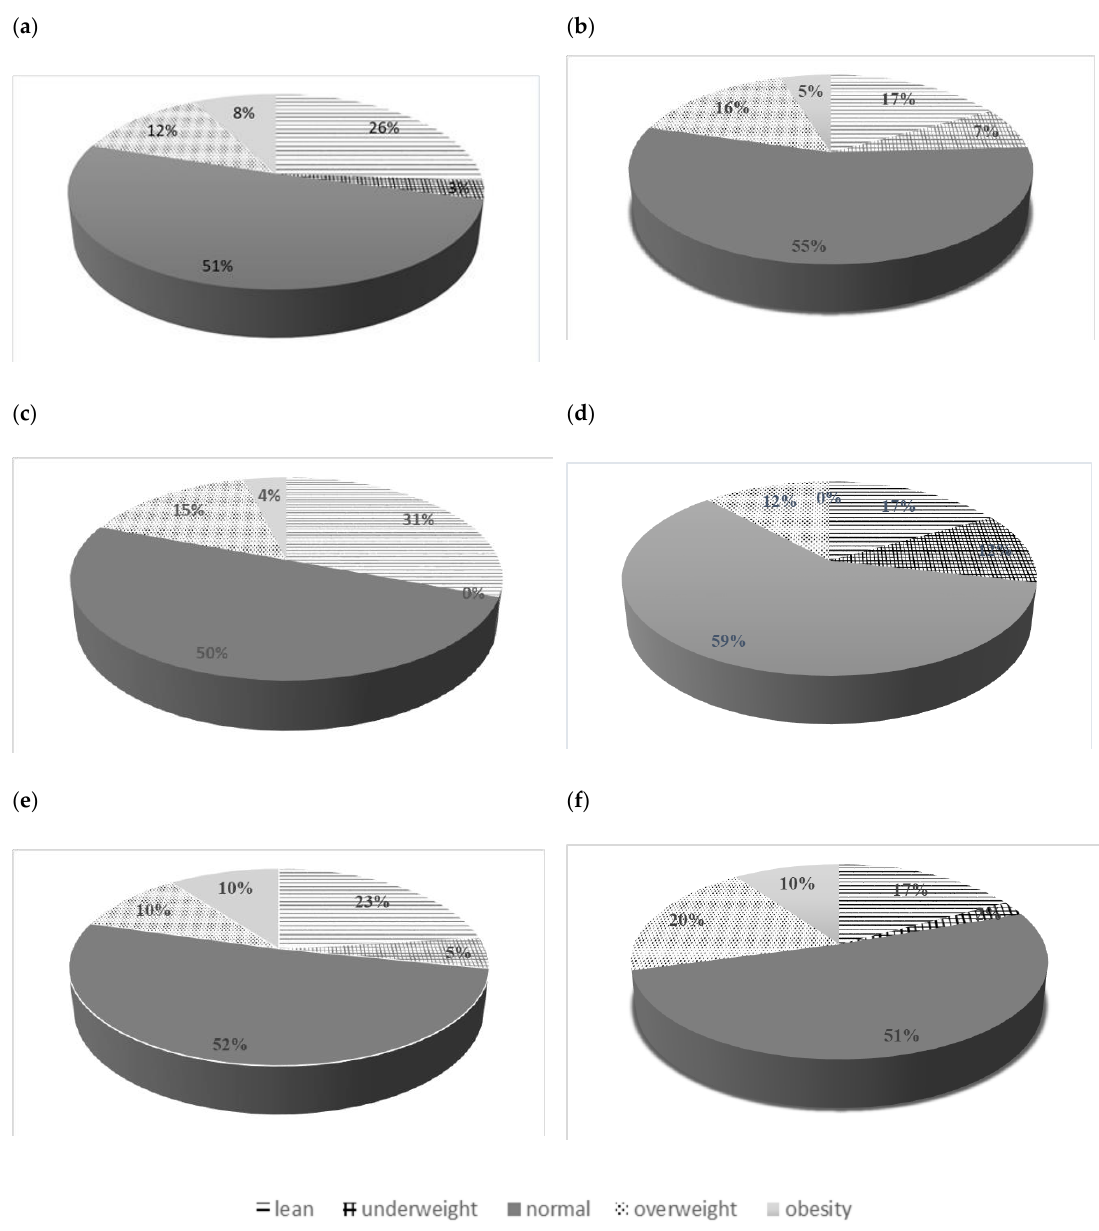
Figure 2. Analysis of the BMI in the groups: ( a ) study group, ( b ) control group, ( c ) girls from the study group, ( d ) girls from the control group, ( e ) boys from the study group, ( f ) boys from the control